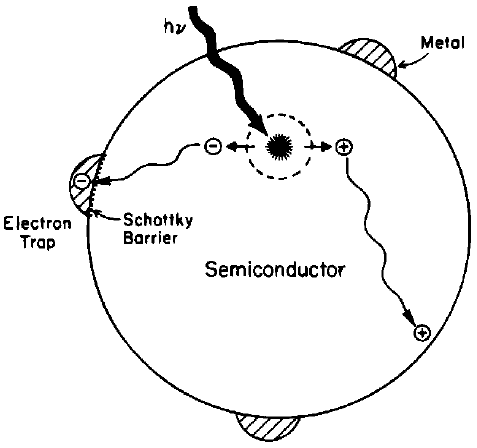
Figure 11. Electron–hole separation of metal-doped semiconductors. Reproduced from work in [112]. Copyright 1995 American Chemical Society.